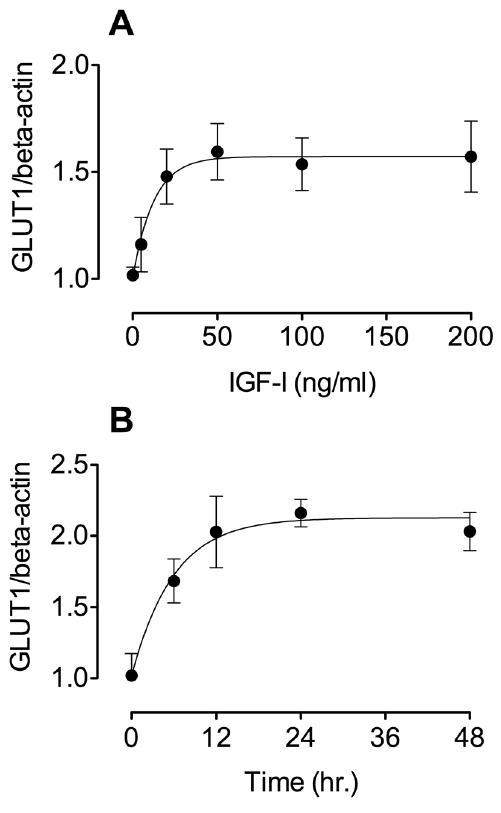
Figure 1. IGF-I effects on BeWo cells. (A) Dose-response : Serum- starved BeWo cells were treated for 24 hr. with IGF-I at doses ranging from 5 to 200 ng/mL. Extracted cell samples were used to measure GLUT1 by slot blotting. The graph shows that treated BeWo cells demonstrate a GLUT1 dose response to IGF-I terminating at a level 1.6- fold greater than control; (p , 0.05, ANOVA, n=3). (B) Time course : Serum-starved BeWo cells were treated with IGF-1 (200 ng/mL) for times ranging from 6 hr. to 48 hr. Extracted cell samples were used to measure GLUT1 by slot blotting. The graph shows that increased levels of GLUT1 were observed by 12 hr. with maximal levels achieved by 24 hr. (p , 0.01, ANOVA, n=3).